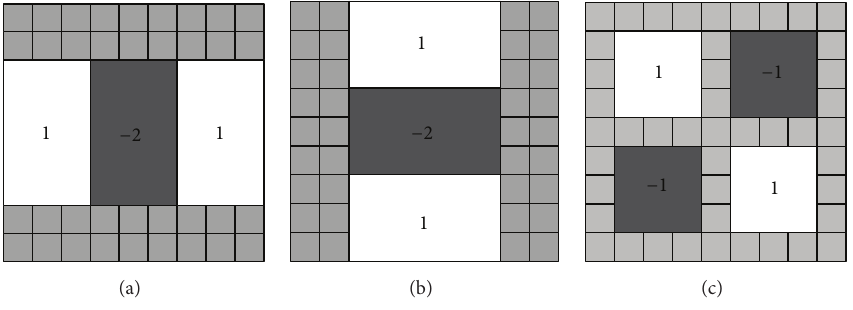
Figure 3: (a) 𝑥 direction, (b) 𝑦 direction, and (c) 𝑥𝑦